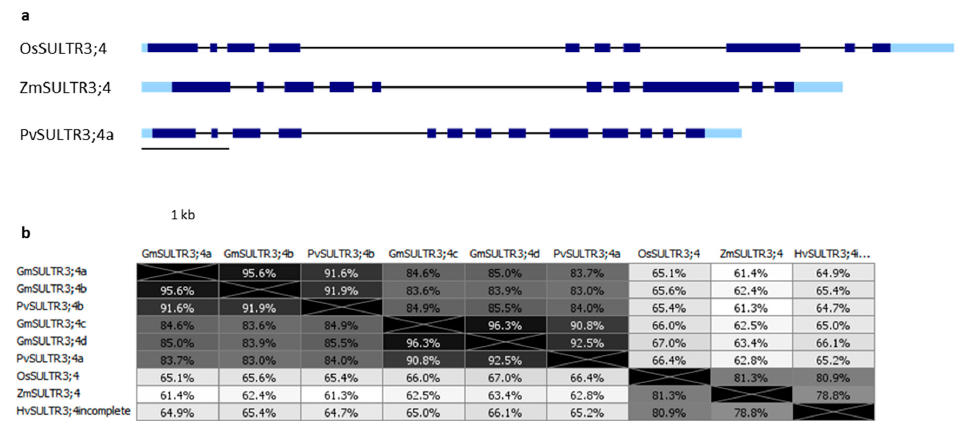
Figure 4. ( a ) Gene structure of OsSULTR3;4 and putative ZmSULTR3;4 and PvSULTR3;4a genes. Light and dark blue rectangles represent UTRs and coding exons, respectively, the black bars correspond to introns. The gene structure was obtained as described in Figure 1a legend. ( b ) Distances between SULTR3;4 proteins, expressed as the percentage of identity. Phylogenies were constructed as described in Figure 1c.